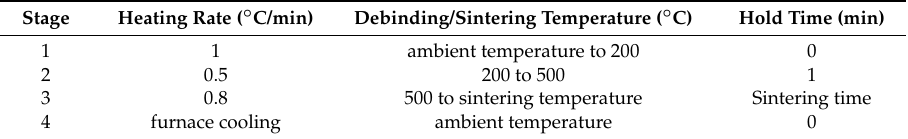
Figure 5. ( a ) TGA curves of binder and the pure ingredients; ( b ) DTA curve of Al–Si (20 wt.%) alloy powders. Table 1. Thermal debinding and sintering